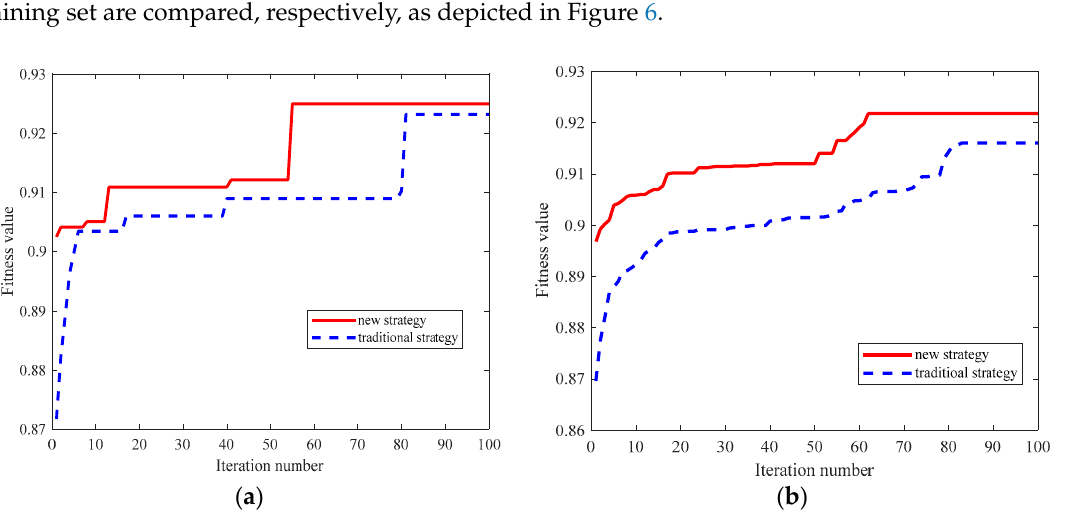
Figure 6. Comparison of convergence curves. ( a ) Best convergence curves; ( b ) Average convergence curves.